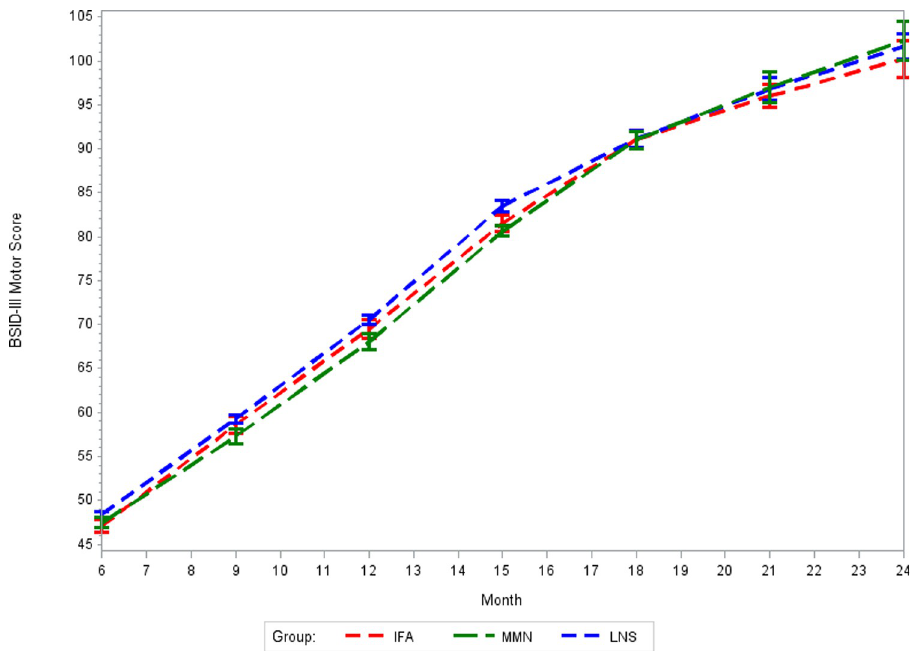
Fig 5. Mean BSID-III motor scores from 6 to 24 months for MMS, LNS, and IFA groups. p -Value for difference in trajectory: MMS vs. IFA = 0.10; LNS vs. IFA = 0.11. BSID-III, Bayley Scales of Infant and Toddler Development III; IFA, iron–folic acid supplements; LNS, lipid-based nutrient supplements; MMS, multiple micronutrient supplements.